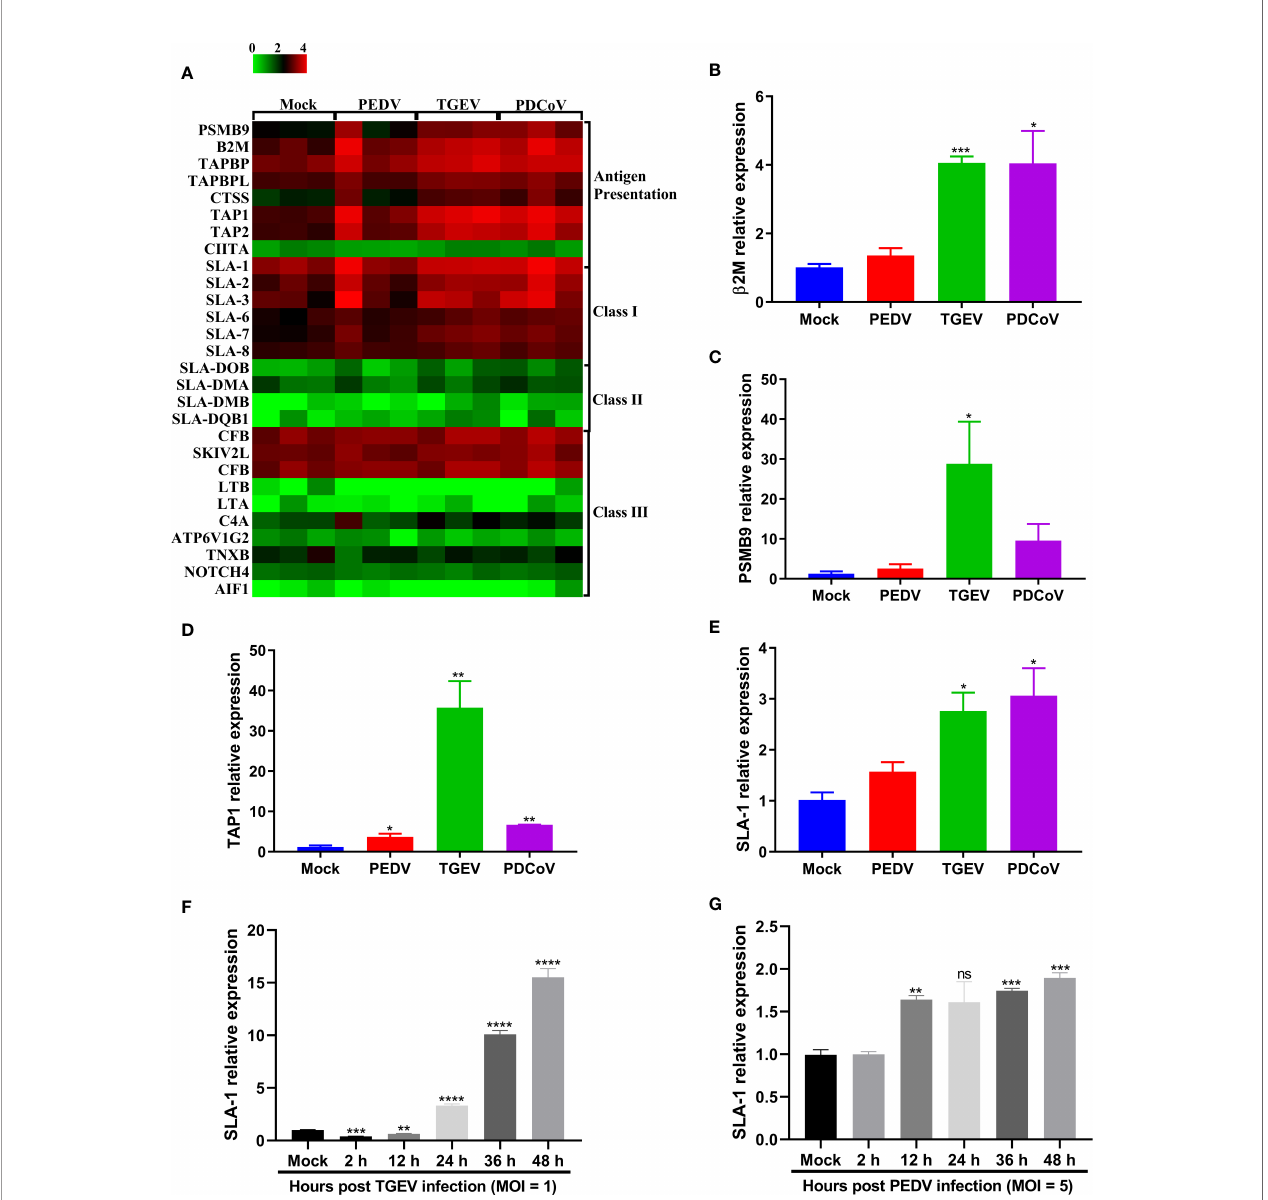
FIGURE 8 | TGEV and PDCoV, not PEDV, robustly upregulate the expression of SLA-I and its associated antigen-presentation genes expression in enteroids. (A) Heat map of SLA molecules and genes associated with antigen-presentation in enteroids following infection with SECoVs. The transcriptional pro fi les of SLA molecules (SLA-I, SLA-II, and SLA-III) and genes associated with antigen-presentation in enteroids following infection with PEDV, TGEV, and PDCoV were determined by RNA-Seq. Data are based on log(RPKM) values (n = 3). (B – E) Veri fi cation of the expression of SLA-I and it ’ s associated with antigen-presentation by RT-qPCR. Jejunal enteroid monolayers were mock-infected or infected with PEDV, TGEV, or PDCoV for 24 h. The mRNA expressions of b 2M (B) , PSMB9 (C) , TAP1 (D) , and SLA-1 (E) were measured by RT-qPCR. (F, G) The expression kinetics of SLA-1 in jejunal enteroids induced by TGEV (F) and PEDV (G) were assessed by RT- qPCR. The differences between groups were compared using the Student ’ s t test. Error bars denote the deviations, and the p values are expressed as follows: * p < 0.05, ** p < 0.01, *** p < 0.005, and **** p < 0.001. ns, not signi fi